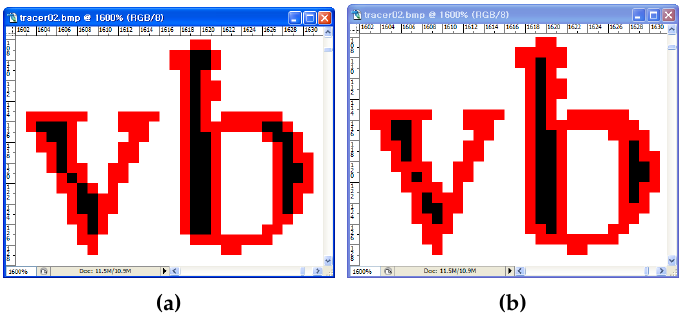
Figure 16. Visual comparison of two contour-tracing methods. ( a ) MSBF; ( b ) the proposed